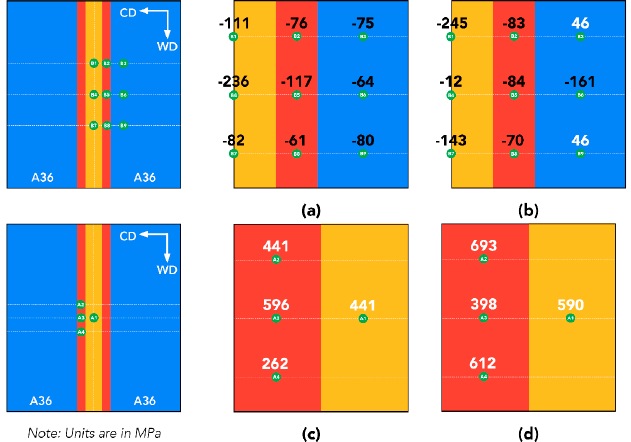
Figure 9. The results of the measured residual stresses: ( a ) Before cladding in WD; ( b ) Before cladding in CD; ( c ) After cladding in WD; ( d ) After cladding in CD.